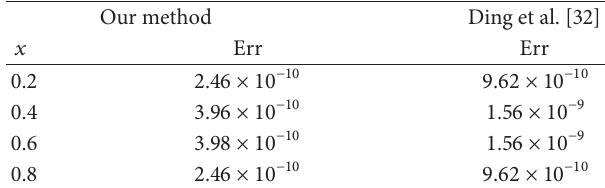
Table 5: Results, with 𝜔 = 𝜋 , for Example